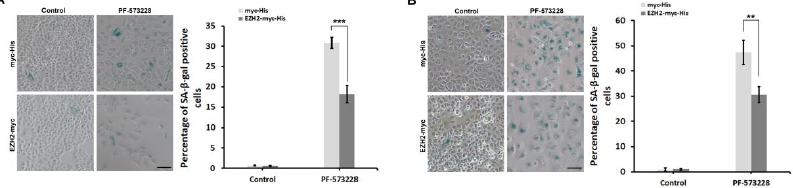
Figure 5. EZH2 overexpression attenuates FAK-inhibitor-induced cellular senescence in non-small cell lung cancer cells. ( A ) A549 or ( B ) H1299 cells overexpressing myc-His or EZH2-myc-His were exposed to 0 or 10 μM PF -573228 for 4 days. SA- β -Gal staining was employed to measure the per- centage of senescent cells (β -gal-positive cells). The ratio of SA- β -gal-positive cells to total cells was calculated and plotted in a bar chart. The data represent the mean ± SD from three independent experiments ( n > 250). ** p < 0.01, *** p < 0.001 according to a Student’s t -test. (Bar scale: 200 μm)